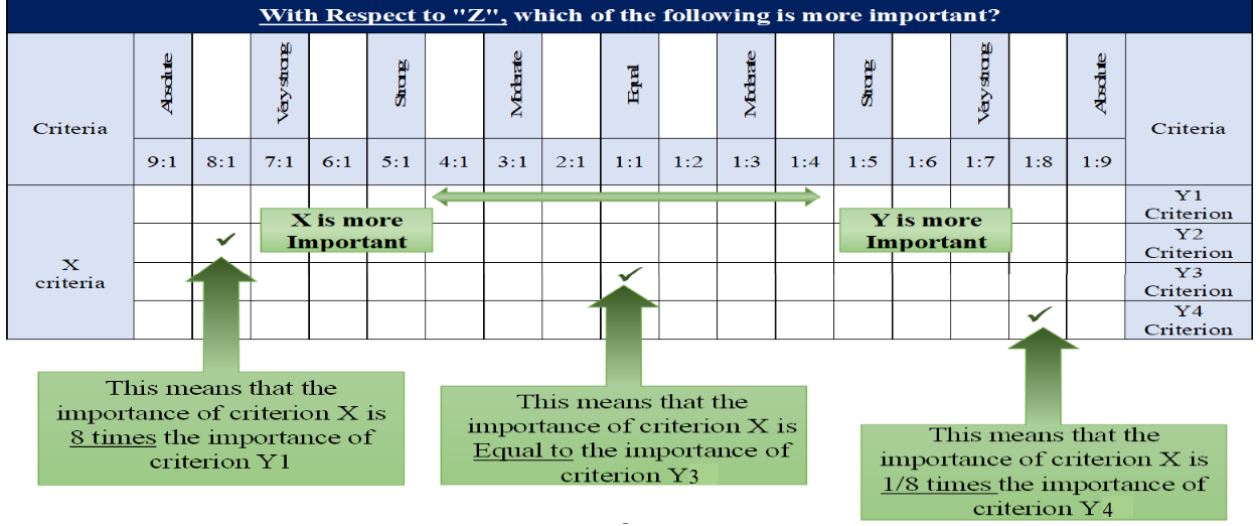
Figure 5. Instructions included to guide the participants in part 3 of the questionnaire .